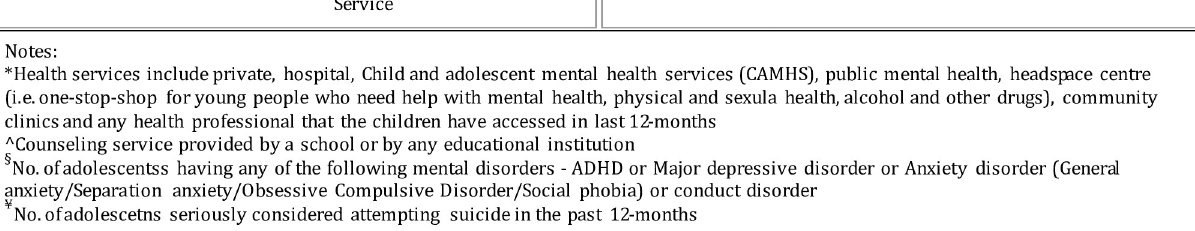
Fig 2. Distribution of mental health services. � Health service include private, hospital, Child and adolescent mental health service (CAMHS), public mental